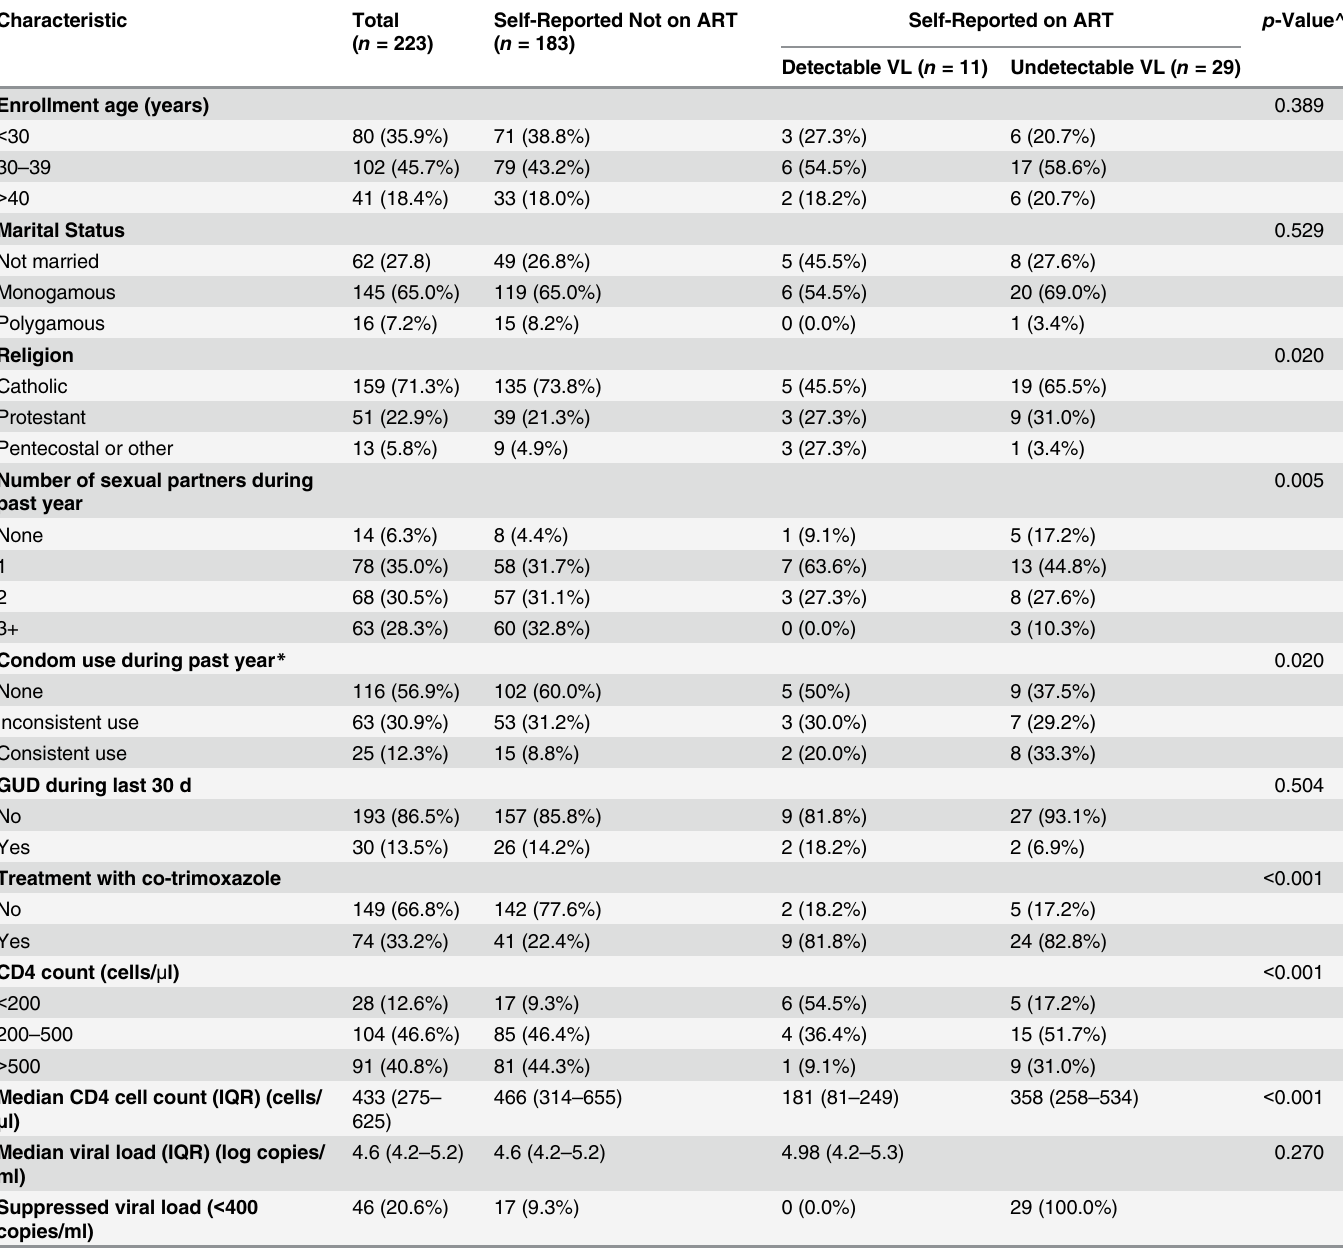
Table 1. Enrollment